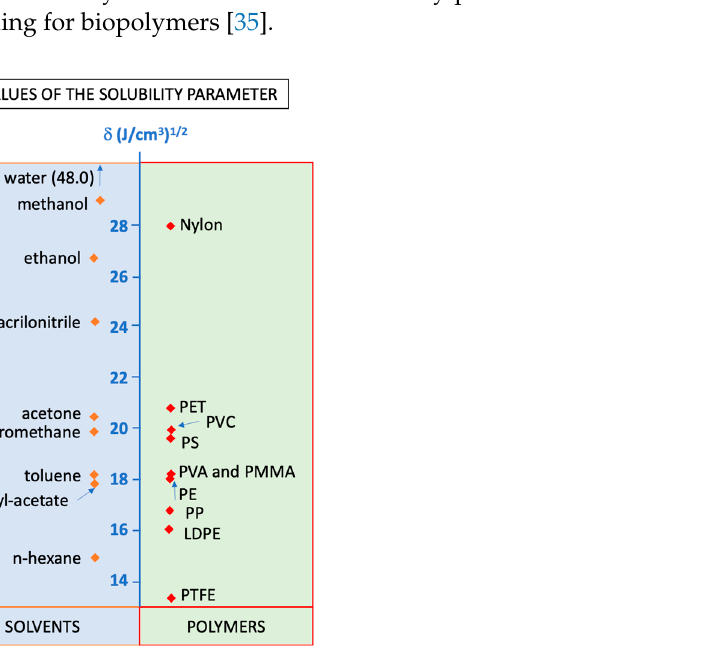
Figure 4. Diagram showing the values of the solubility parameter, δ [(J/cm 2 ) 1/2 ], for different solvents and polymers.